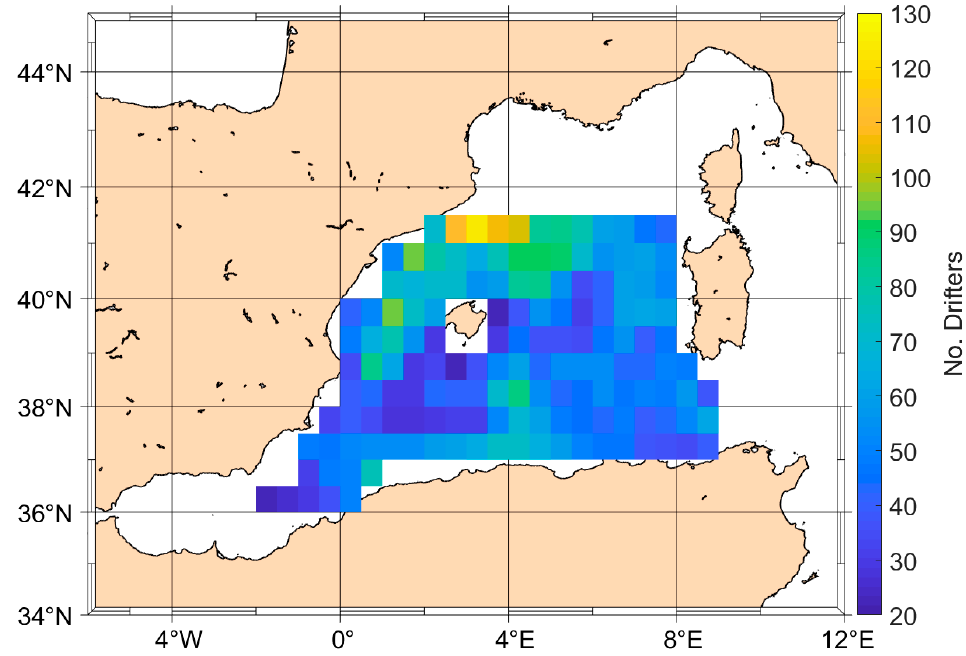
Figure 2. Data coverage of the drifters within the area of study for the period 1985–2016.